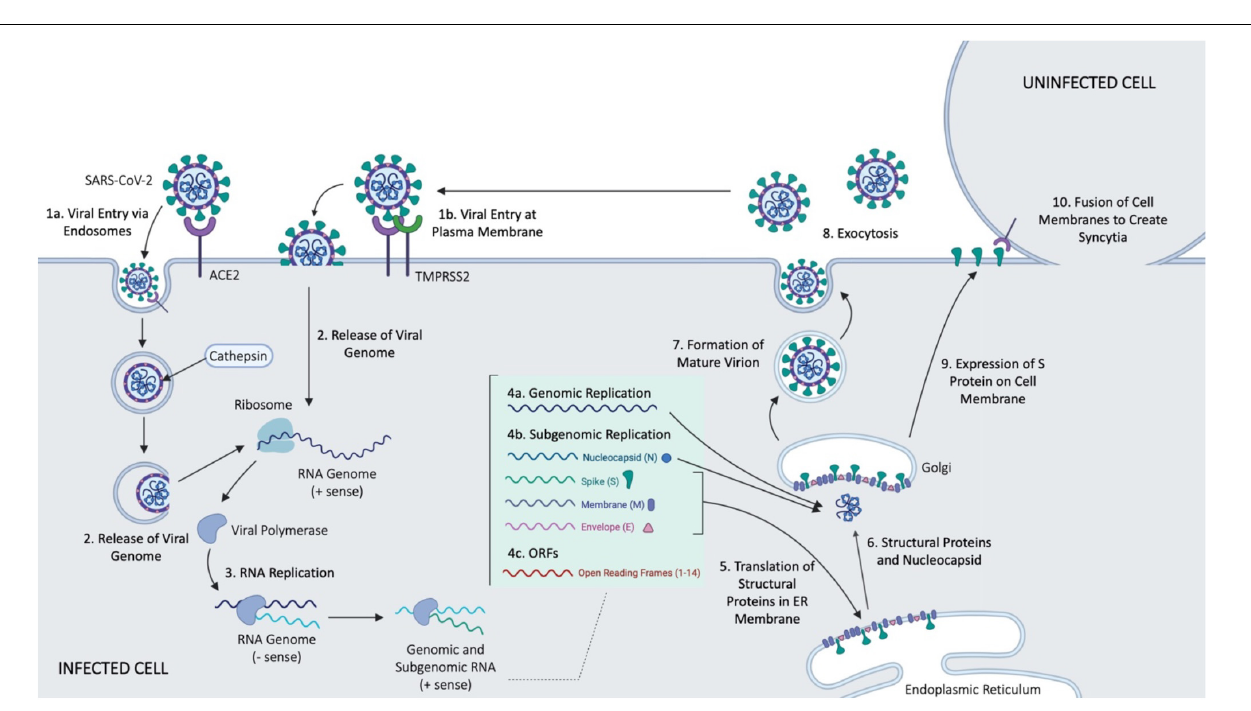
FIGURE 2 | Main events in cellular entry and trafficking of CoV. Some of the outlined steps were inferred form the SARS-CoV infection of host cells. Figure courtesy of